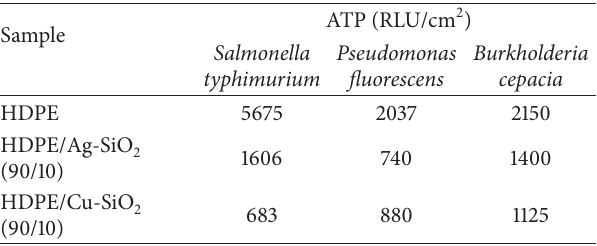
(90/10) composites surface deter- 2